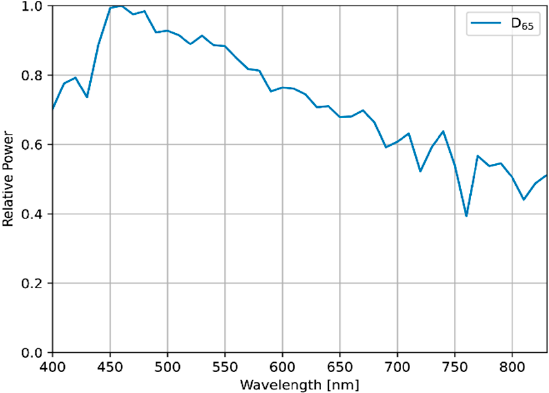
Figure 5. The SPD of D65, which was used as the reference light source.